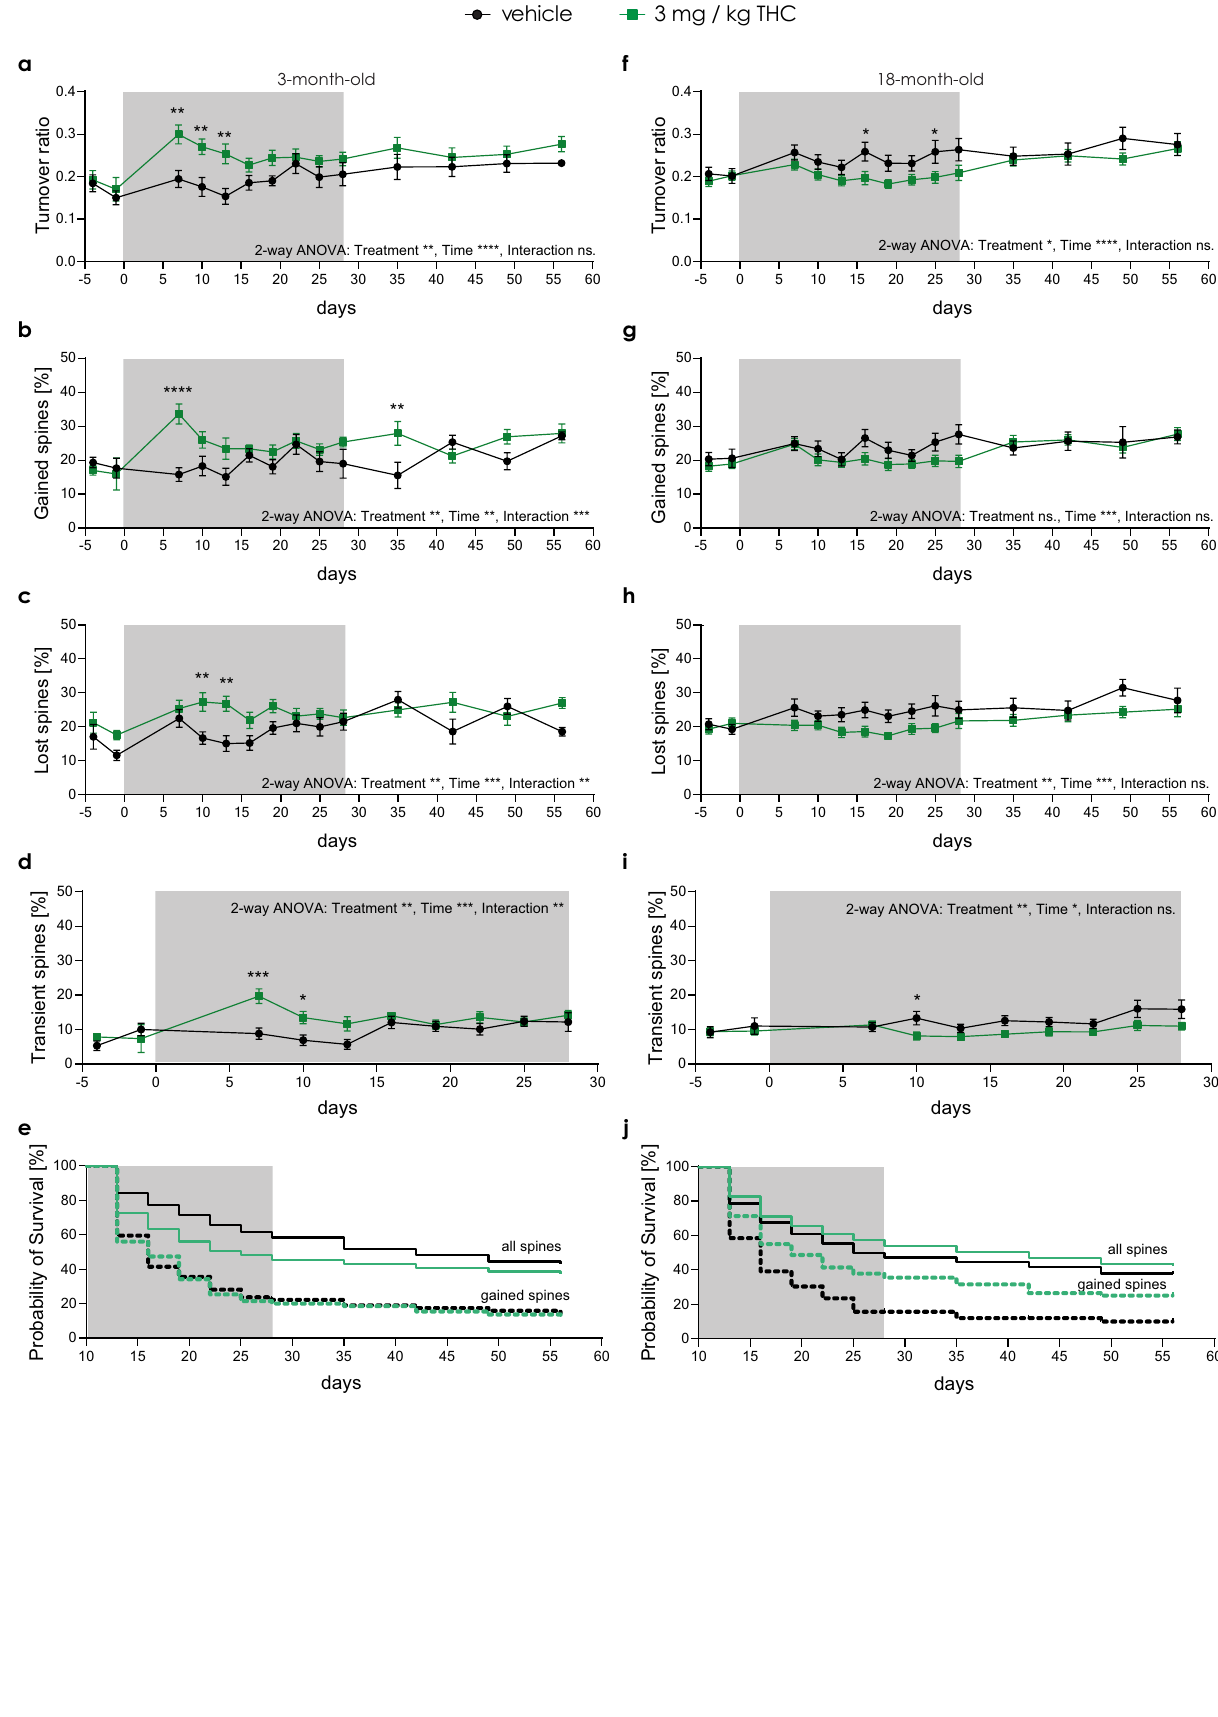
all spines gained